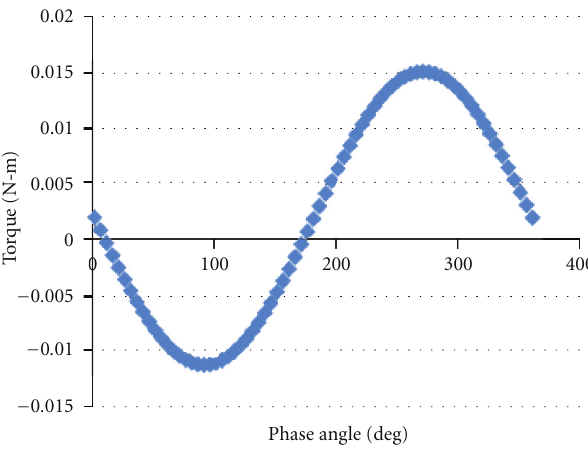
Figure 9: Rotor angle-87.5 ◦ : phase angle versus torque.